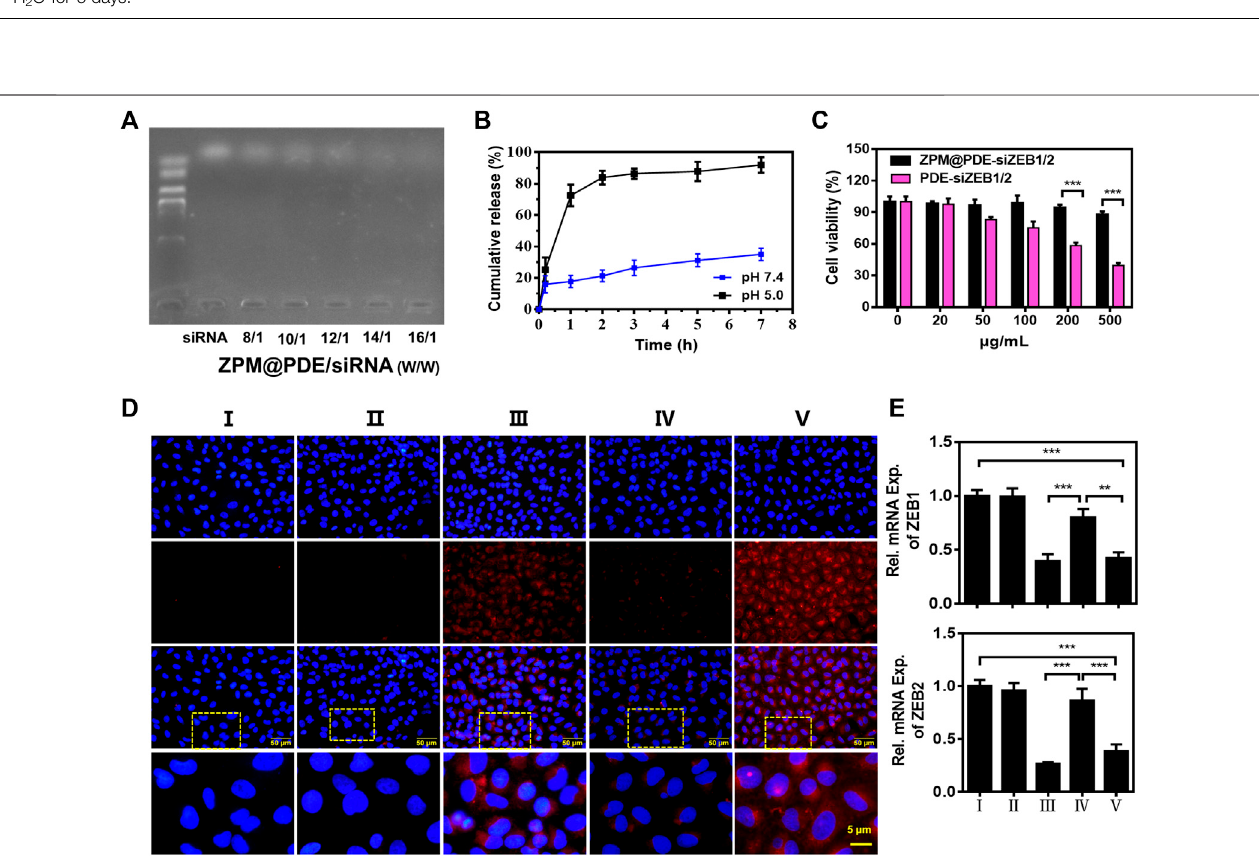
FIGURE 3 | (A) Gel retardation assay of ZPM@PDE/siZEB1/2 with different mass ratio, (B) siZEB1/2 release from ZPM@PDE-siZEB1/2 at pH 5.0 or pH 7.4 over time, (C) CytotoxicityofPDE@siZEB1/2andZPM@PDE-siZEB1/2, (D) UptakeofZPM@PDE-Cy5-siZEB1/2(red) invitro .NucleistainedwithDAPInucleardye(blue),and (E) Silencing ef fi cacy of ZPM@PDE-siZEB1/2 in vitro . ( n = 3, * p < 0.05, ** p < 0.01, *** p < 0.001). For each group: Ⅰ , Control; Ⅱ , Naked CY5-siZEB1/2; Ⅲ , Lip 2000-CY5- siZEB1/2; Ⅳ , ZPM@PDE-CY5-siZEB1/2 (pH 5.0); Ⅴ , ZPM@PDE-CY5-siZEB1/2 (pH 7.4).